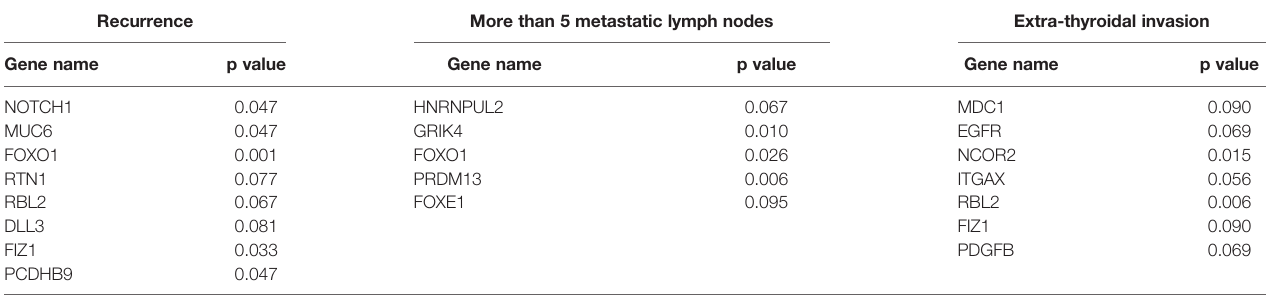
TABLE 2 | List of aggressive PTC special mutated genes by fi sher ’ s test in different groups. Recurrence More than 5 metastatic lymph